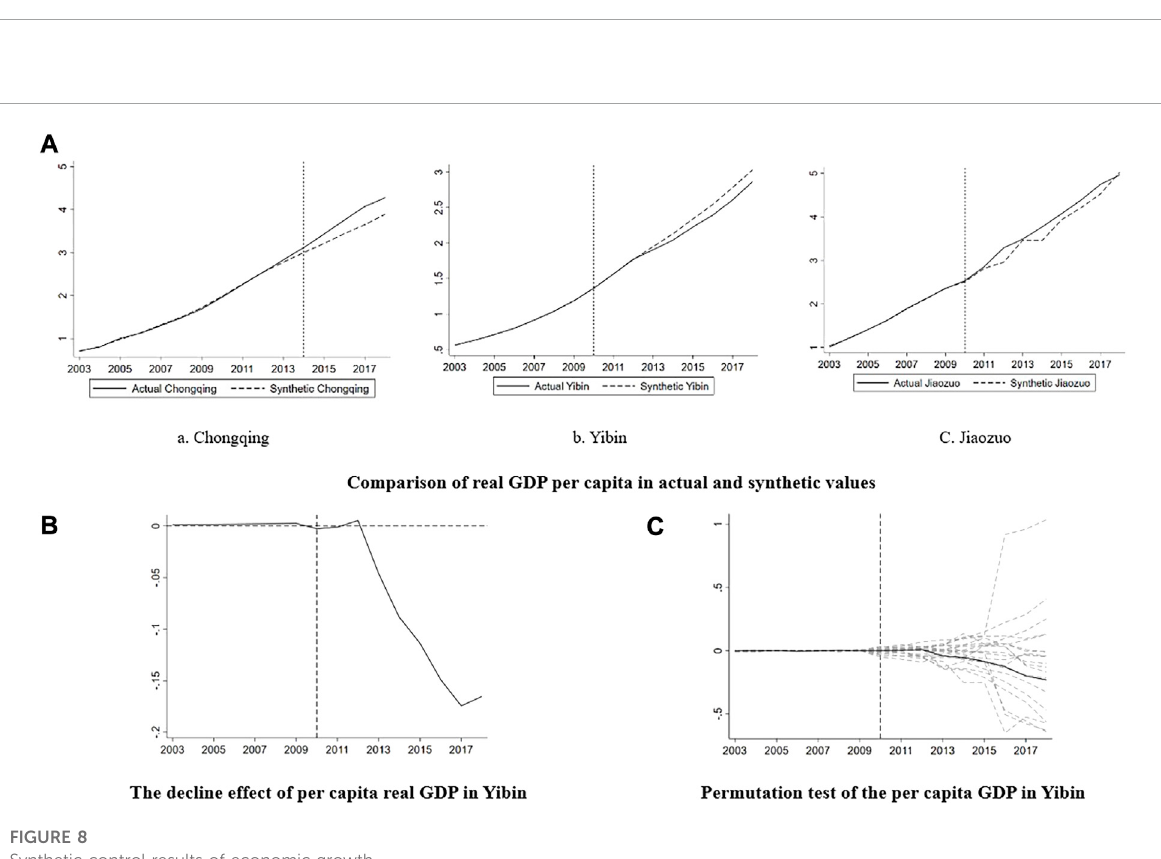
FIGURE 7 Parallel trend test for enterprises ’ industrial pollutant emissions. Note: The dashed line perpendicular to the horizontal axis indicates the 95% con fi denceintervalfortheestimatedregressioncoef fi cient.Thehorizontalaxisindicatestheyearofpolicyimplementation.Beforeindicates “ before the policy implementation, ” and after indicates “ after the policy implementation ” .